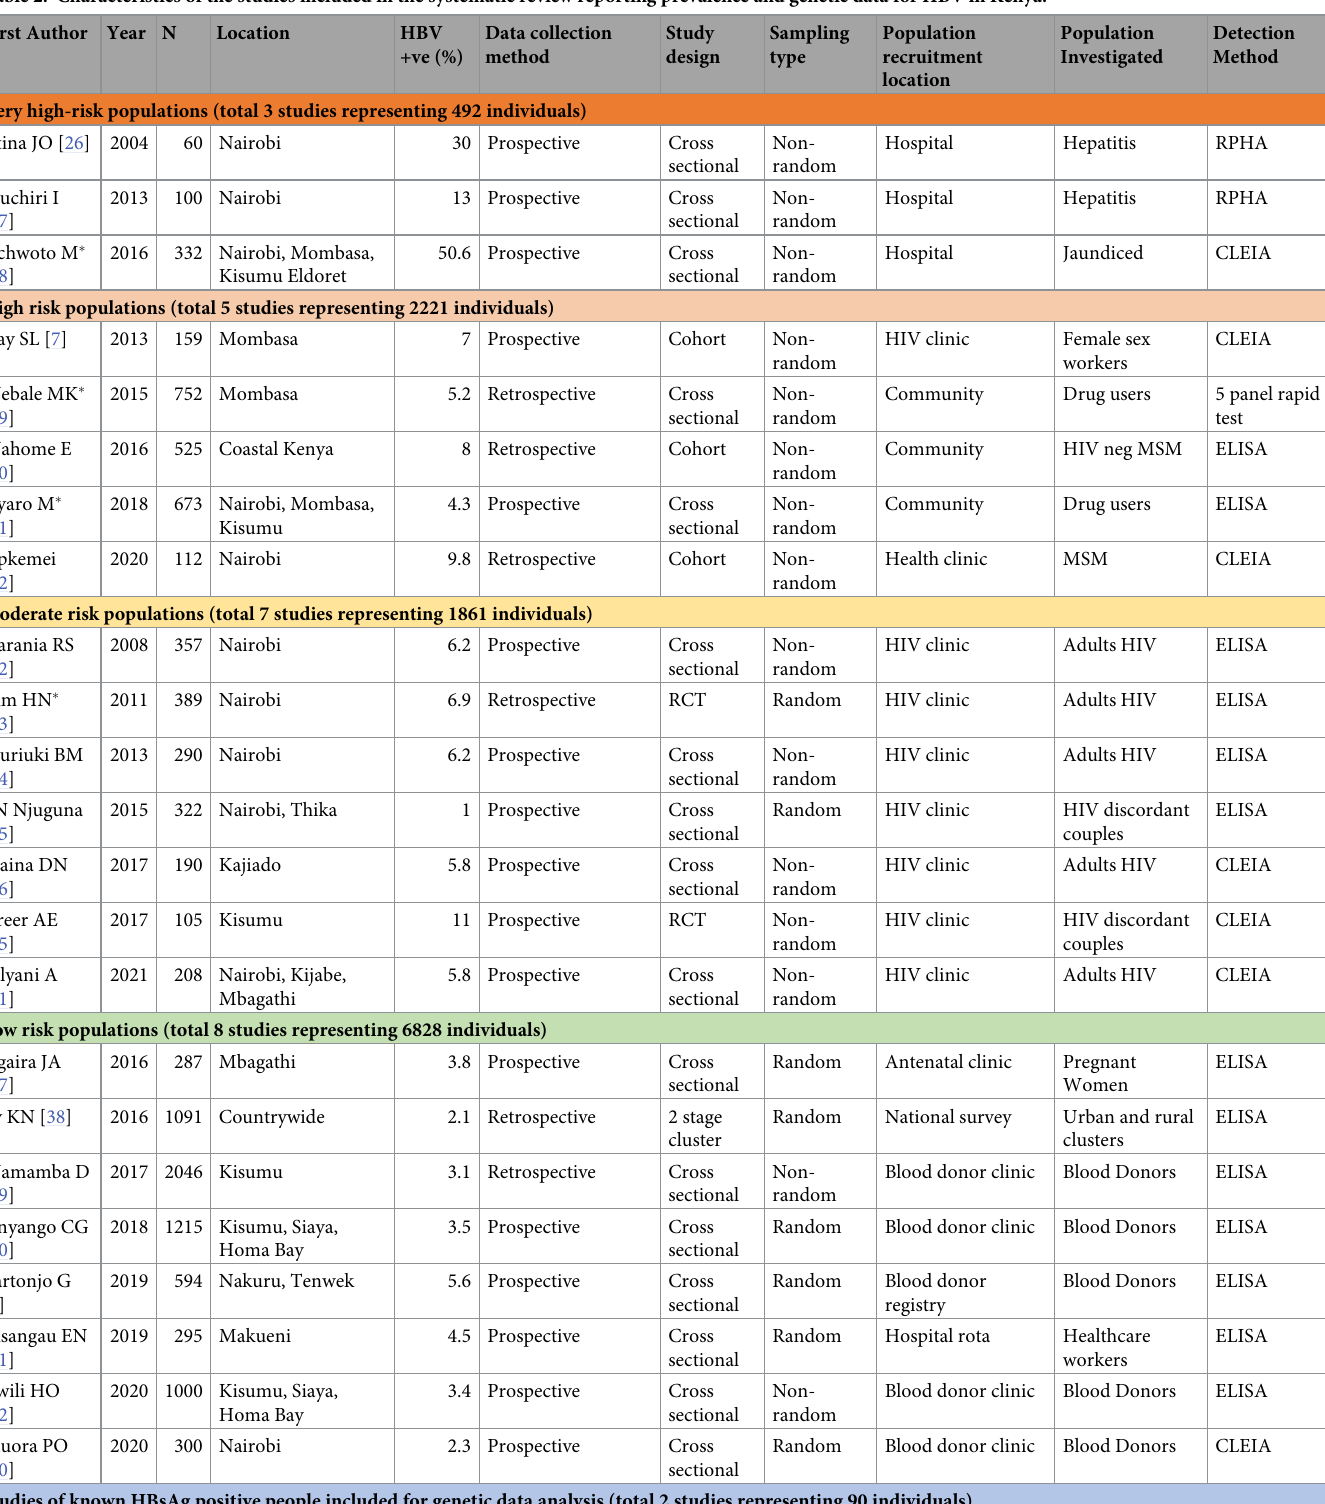
Table 2. Characteristics of the studies included in the systematic review reporting prevalence and genetic data for HBV in